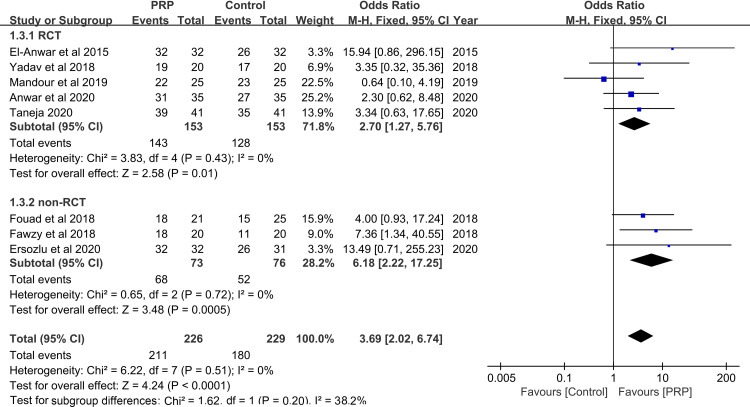
Forest plot of closure rate between PRP and control group.PRP: platelet-rich plasma; RCT: randomized controlled trial.